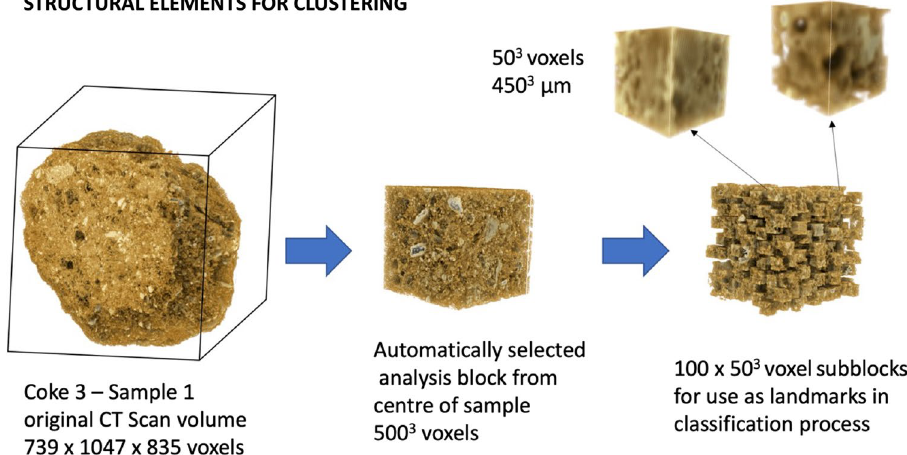
Fig. 4 Example of how subblocks of microstructure are generated for